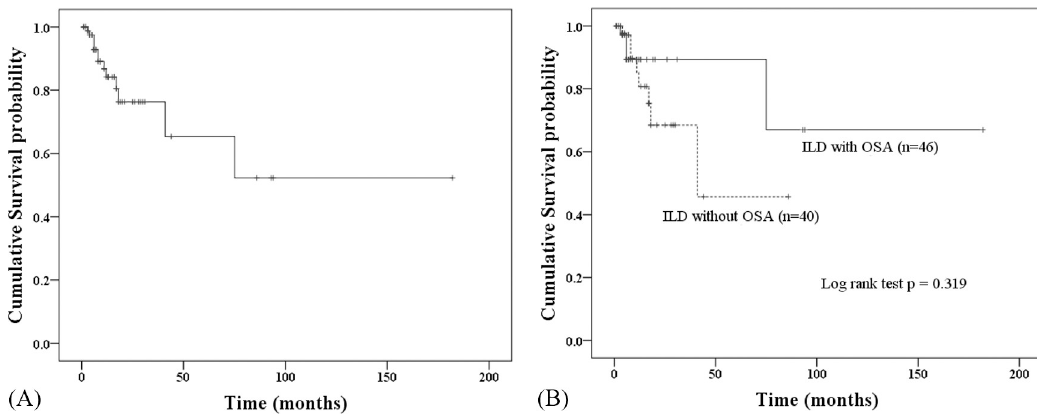
Fig 1. Kaplan–Meier survival curves in patients with interstitial lung disease. (A) Survival curves of total patients with interstitial lung disease (ILD); (B) Comparison of survival curves between ILD patients with and without obstructive sleep apnea.